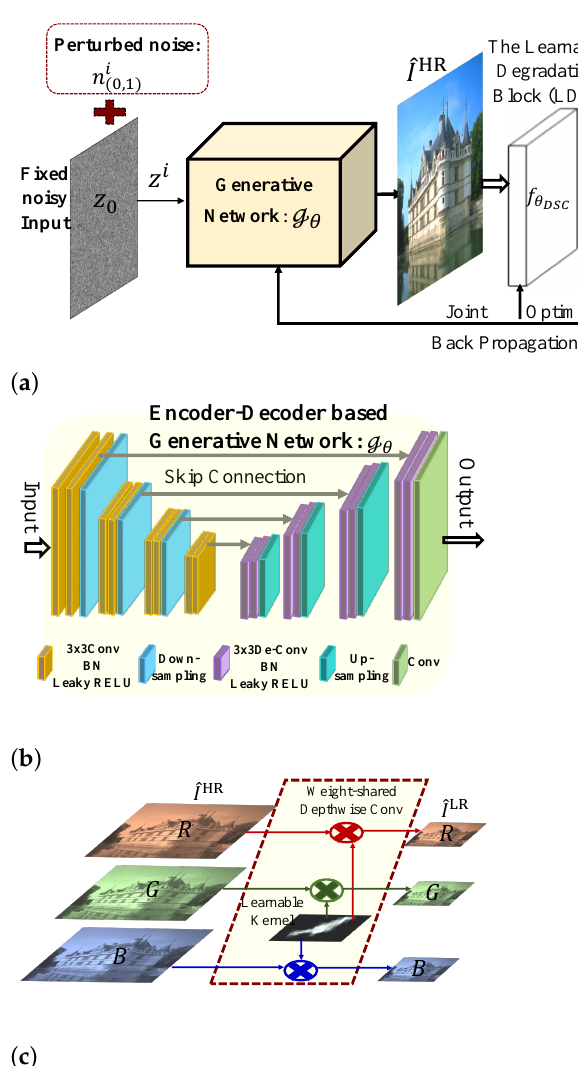
Figure 1. The conceptual scheme of the proposed blind SR framework with deep unsupervised learning (BSR-DUL). ( a ) The overall architecture of the proposed BSR-DUL. ( b ) The generative network. ( c ) The learnable degradation